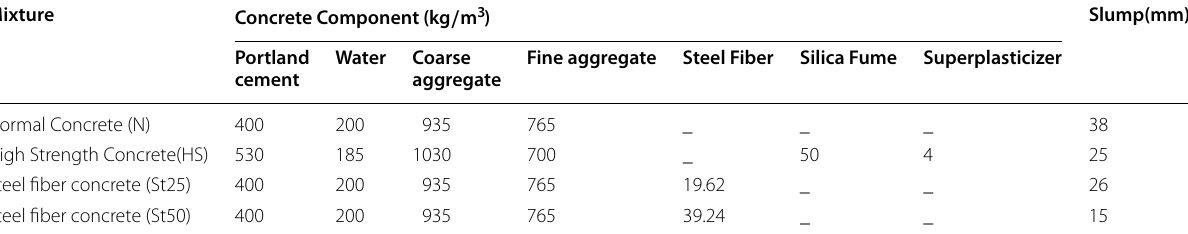
Table 2 Mixing plan.